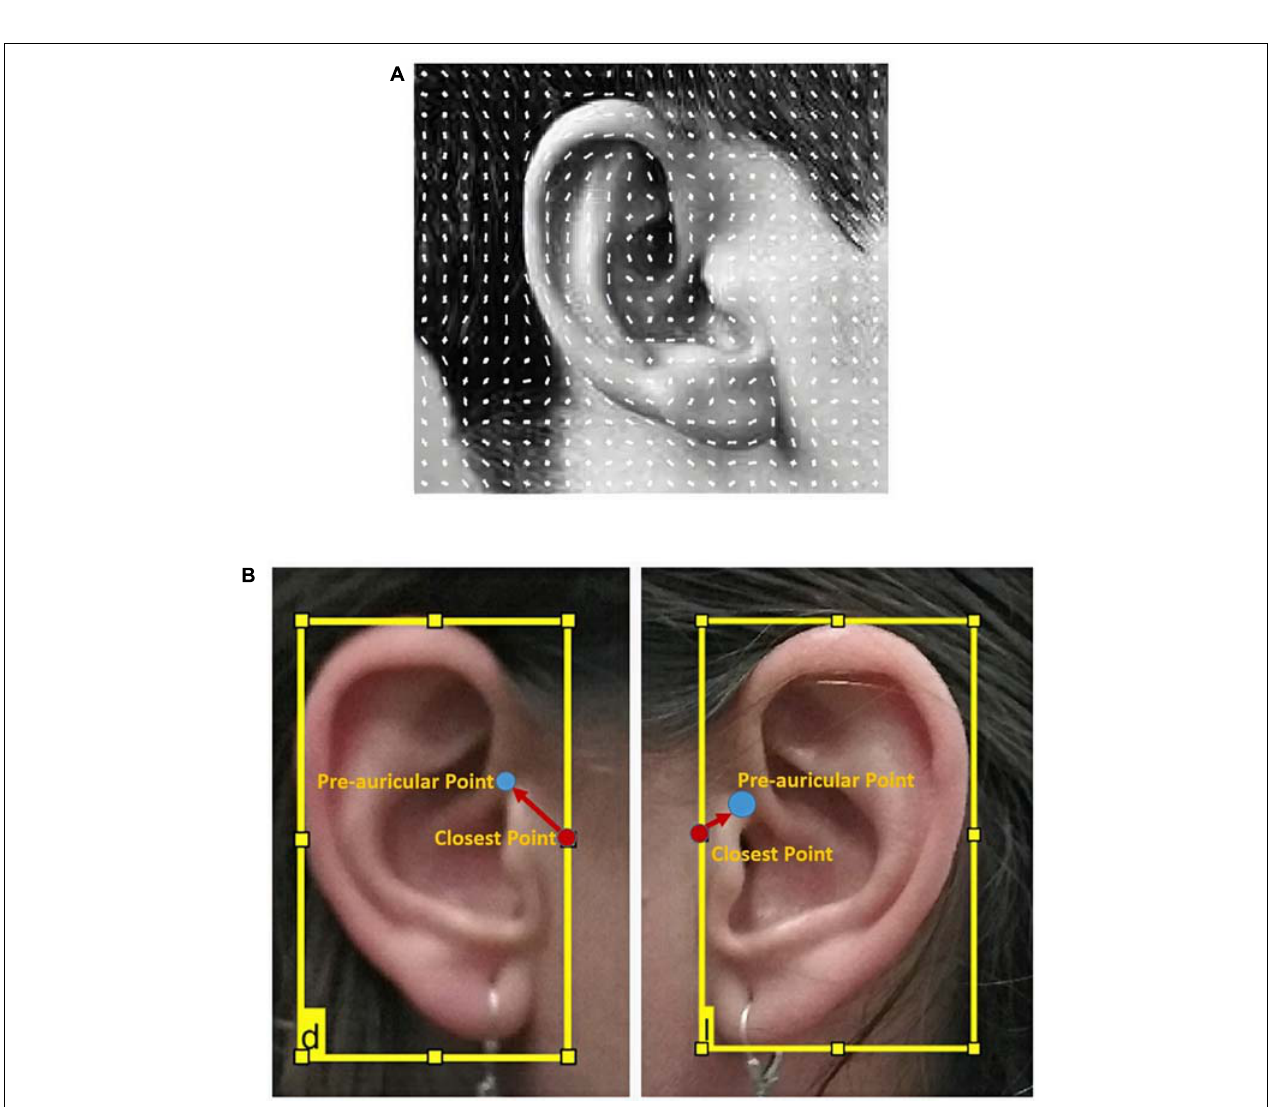
FIGURE 7 | (A) Typical histogram of oriented gradients of one ear and (B) correction of the preauricular points.